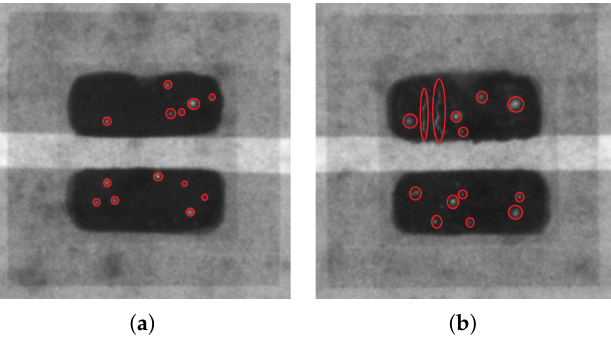
Figure 7. ( a ) X-ray analysis of an LED that has not undergone TCT, red circles underline the voids present in the joint. ( b ) X-ray analysis of a failed SJL with voids and cracks pointed out by red